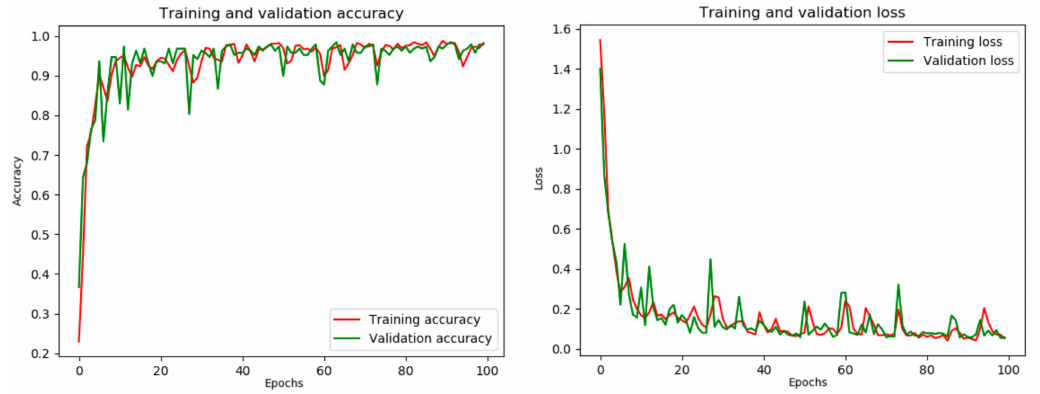
Figure 7. Accuracy and loss curves over 100 epochs of CNN